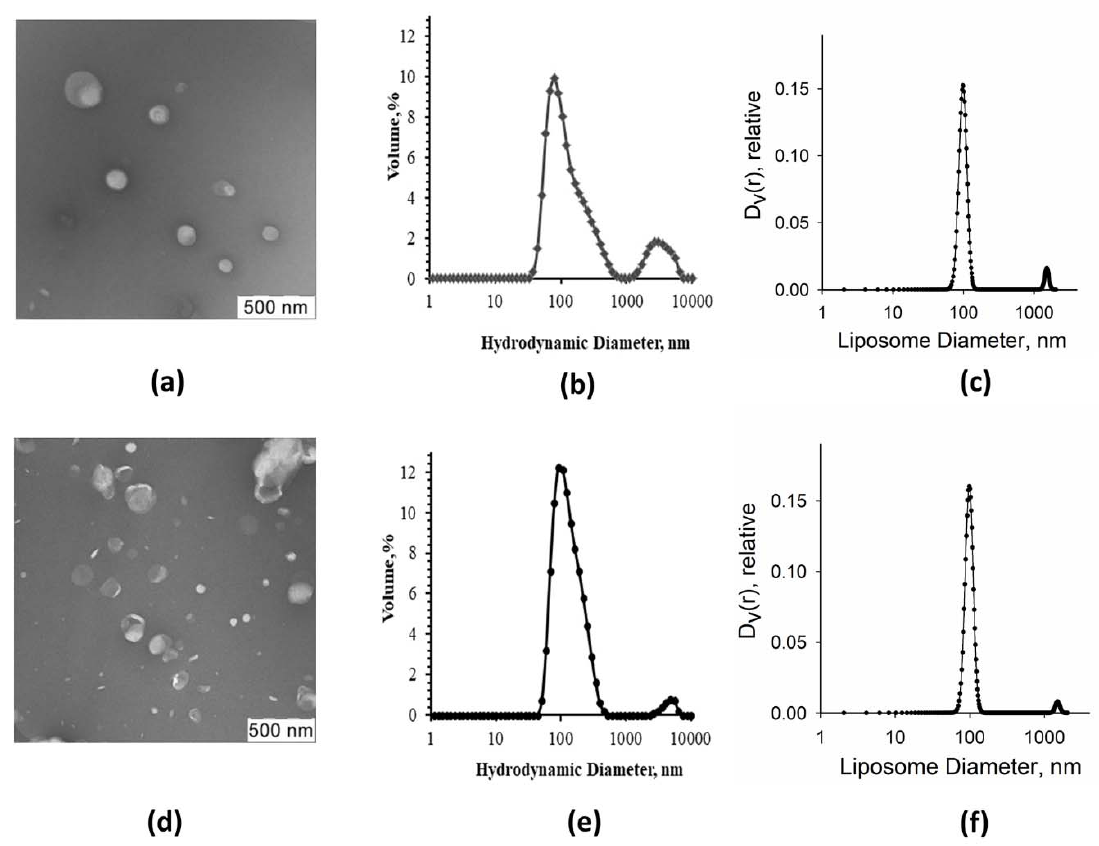
Figure 5. Size estimation of native liposomes and proteoliposomes. Represented are the EM images ( a,c ), the DLS analysis ( b,e ), and the SAXS analysis results ( c,f ) obtained for native liposomes ( a,b,c ) or proteoliposomes ( d,e,f ).